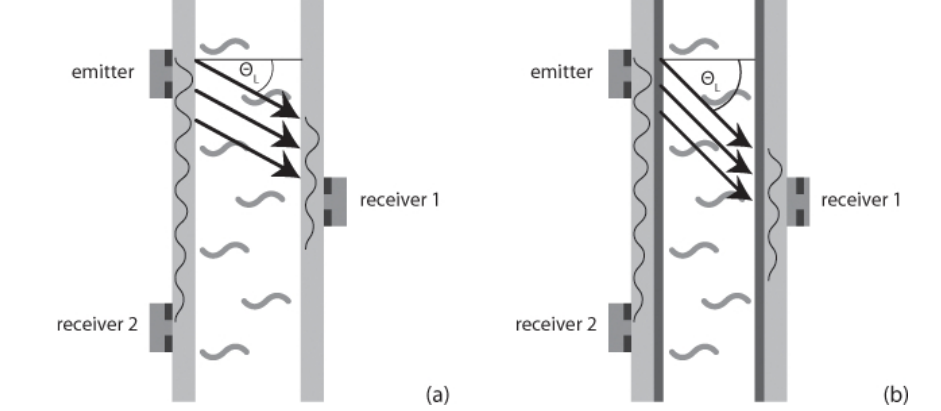
Figure 1. (a) The measurement setup for the new acoustic sensor principle consists of one emitter and two receivers attached to the outer side of a tube or a container. (b) A formation of a coating inside the tube or container results in changes of the transmission times and the amplitudes of the acoustic signals on receiver 1 and receiver